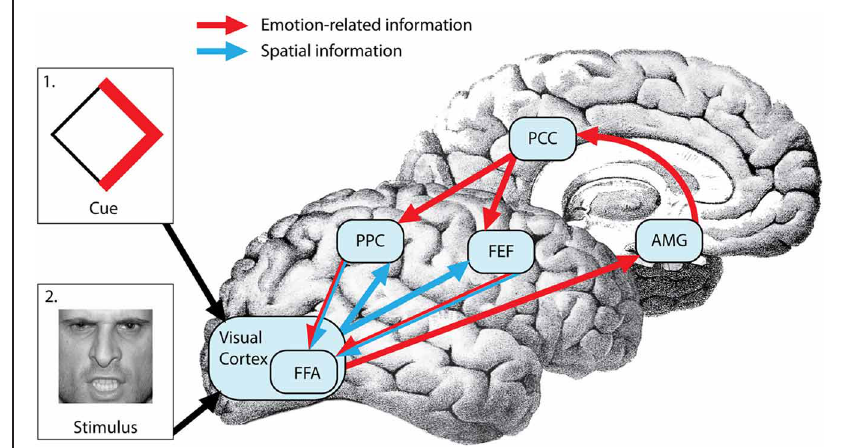
FIGURE 1 | Neural mechanisms of top-down emotional modulation of attention. Prior information regarding upcoming attentional targets (via cue depicted in box 1) is processed in the visual cortex (VC). Emotion-related information from the VC is evaluated in the amygdala (AMG) and projected to the posterior parietal cortex (PPC) and frontal eye fields (FEF) through the post cingulate cortex (PCC). On the other hand, spatial information encoded in the cue is projected from the VC to the FEF and PPC. The FEF and PPC form an integrated search template (a “top-down salience map”) that combines the spatial coordinates of the an event with its emotional salience and bias the visual cortex (more specifically fusiform face area or FFA in this case because the attentional target isaface) in preparation for the search process resulting in faster detection of the target (depicted in box